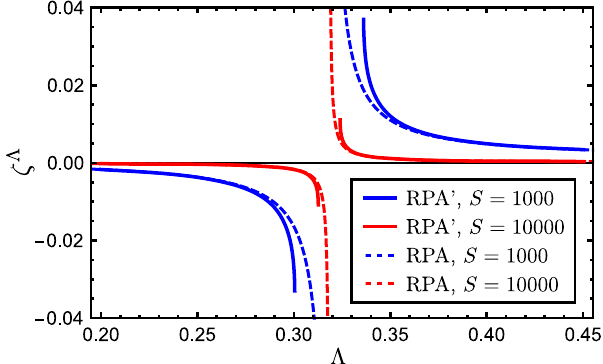
FIG. 24. Plot of the Λ flow of ζ Λ which, in the case of (i) RPA, refers to the denominator of Eq. (A5) and, in the case of (ii) RPA 0 , refers to the k -independent expression in the second and third line of Eq. (A11) with J 1 ¼ x ¼ 1 . Blue and red curves denote spin S ¼ 1000 and S ¼ 10000 , respectively. The divergence in RPA at Λ ¼ J = π isregularized inthe RPA 0 scheme. No data are plotted in 1 the interval where the susceptibility becomes